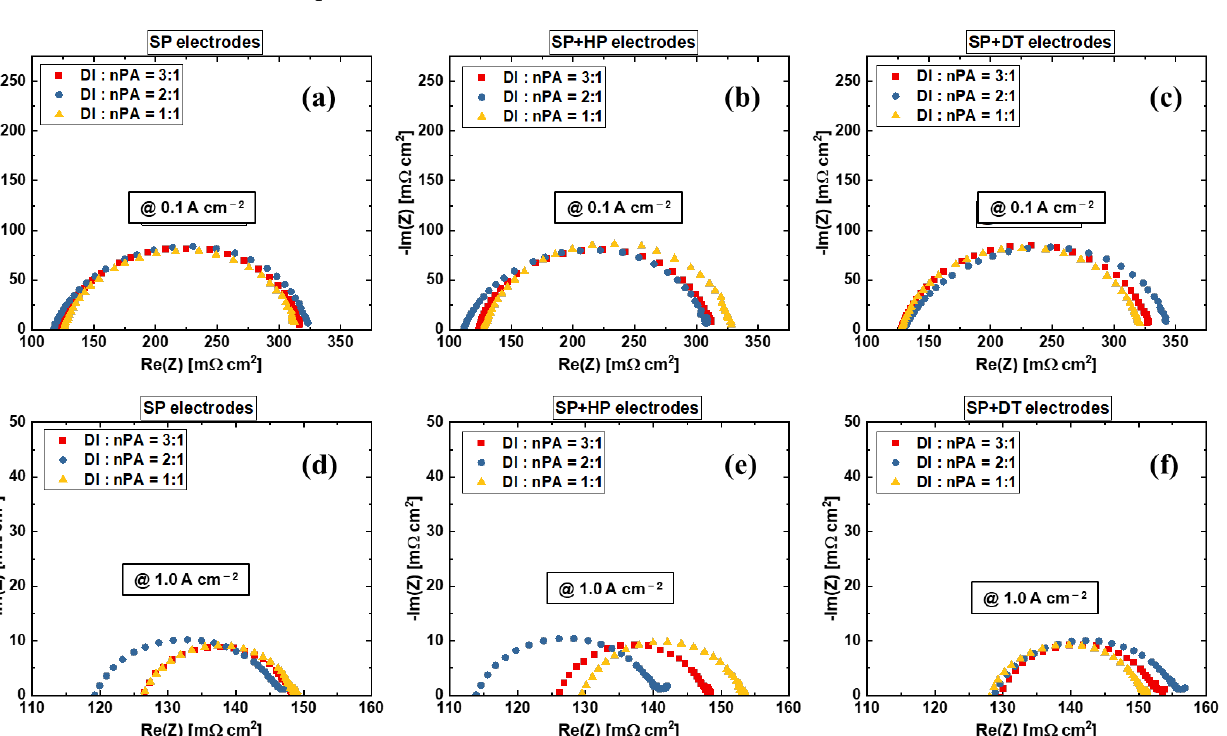
Figure 9. EIS comparison at ( a – c ) 0.1 A cm − 2 and ( d – f ) 1.0 A cm − 2 with different anode electrode fabrication methods ( a , d ) direct ultrasonic spray, ( b , e ) ultrasonic spray and hot press, and ( c , f ) ultrasonic spray and decal transfer.